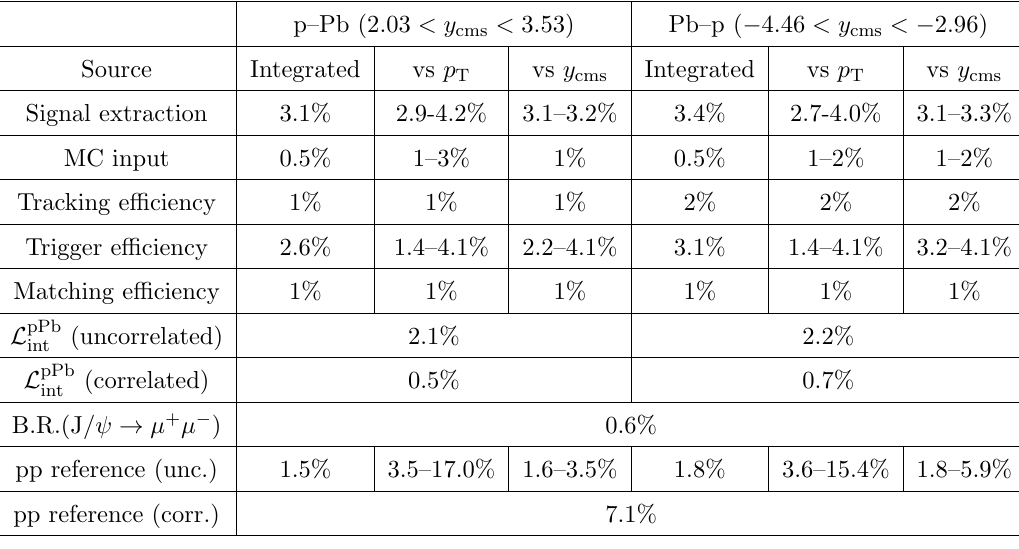
Table 1 . Summary of systematic uncertainties on the calculation of cross sections and nuclear modi(cid:12)cation factors. Uncertainties on signal extraction, MC input and e(cid:14)ciencies are considered as uncorrelated over p T and y cms . The uncertainties on the luminosity and on the pp reference result from the combination of two contributions, one uncorrelated and the other correlated, which are separately quoted. The uncorrelated uncertainty on luminosity includes the contribution of the systematic uncertainty on F norm as well as a 1.1% (0.6%) contribution due to the di(cid:11)erence between the luminosities obtained with the V0 and T0